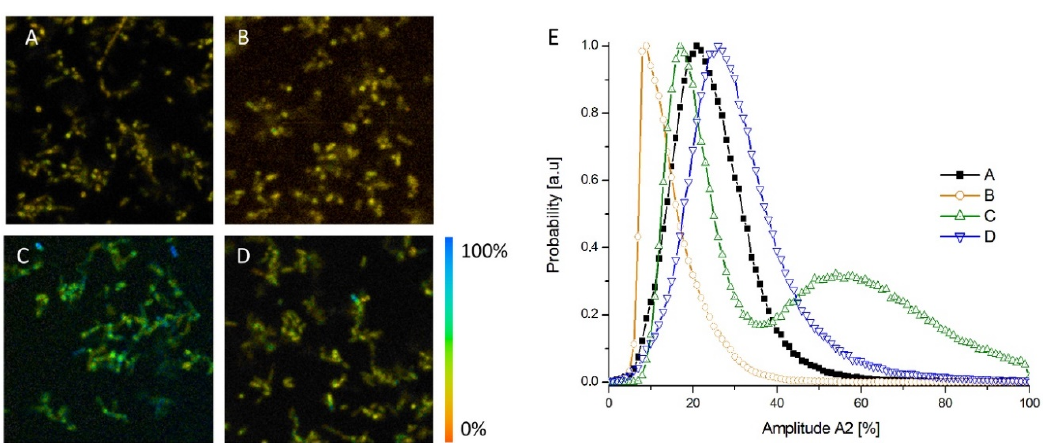
Figure 4. Representative images of spatial distribution of the relative amplitudes of long-lifetime component estimated from fluorescence lifetime imaging (FLIM) images: control conditions ( A ), after 5 cycles of cascade reaction-free cells ( B ), after 5 cycles of cascade reaction in entrapped cells ( C ), and control cells with addition of 10 mM glucose ( D ). Cumulative histogram of the relative amplitudes of long-lifetime decay component ( E ) corresponding to cells in cases ( A – D ). Distributions were computed from N = 4–7 images and normalized to their respective maximum.